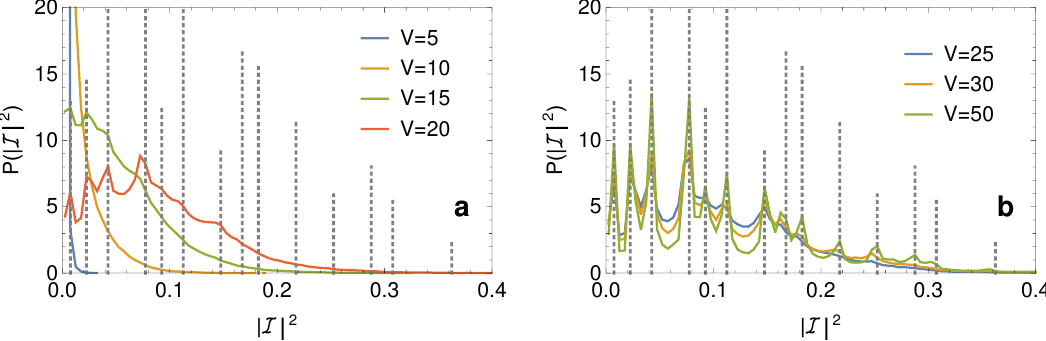
Figure 5: Probability distribution of modulus-squared imbalance for system size N = 78. The imbalance of the configuration basis states are shown as dashed lines. Panel a